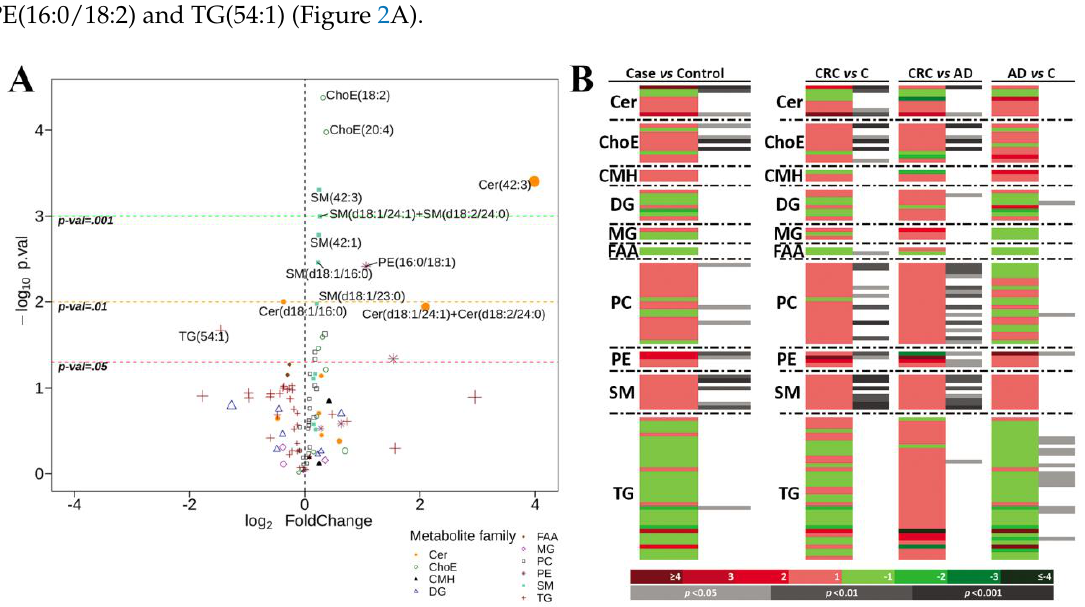
Figure 2. Volcano plot representation of metabolic changes in stools from control, CRC and AD sample groups. [log10 ( p -value) vs. log2 (fold-change)] for the comparison between healthy individuals and patients with advanced neoplasia (CRC and AD). The shape and colour of the points indicates metabolite family, while the size is determined by the absolute value of the log2 Fold Change ( A ). Heatmap of metabolites altered in stools from control, CRC and AD sample groups ( B ).